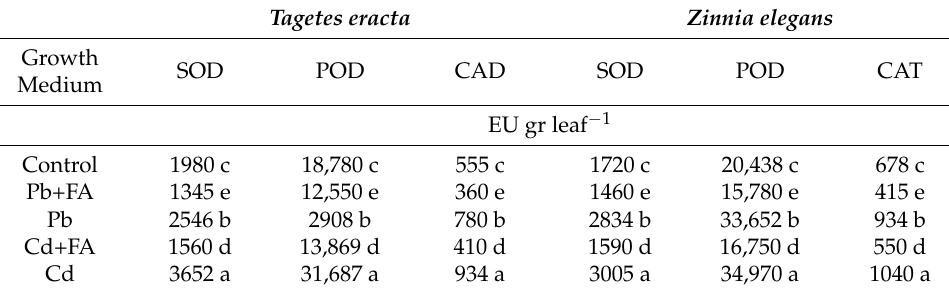
Table 7. Antioxidant enzyme activity of Tagetes eracta and Zinnia elegans